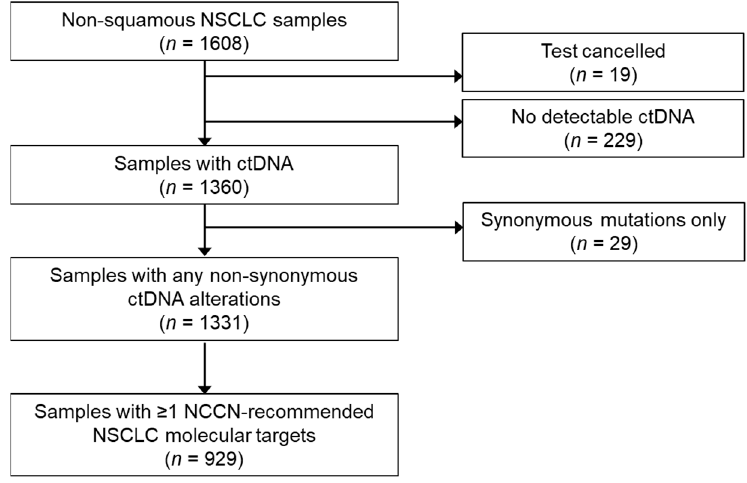
Figure 1. Characteristics of non-squamous NSCLC samples tested. Abbreviations: ctDNA, circulating